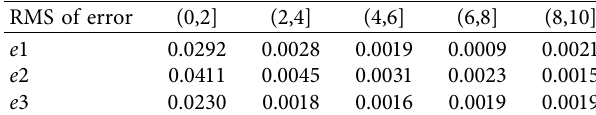
Table 2: RMS values of errors by MFASMC.